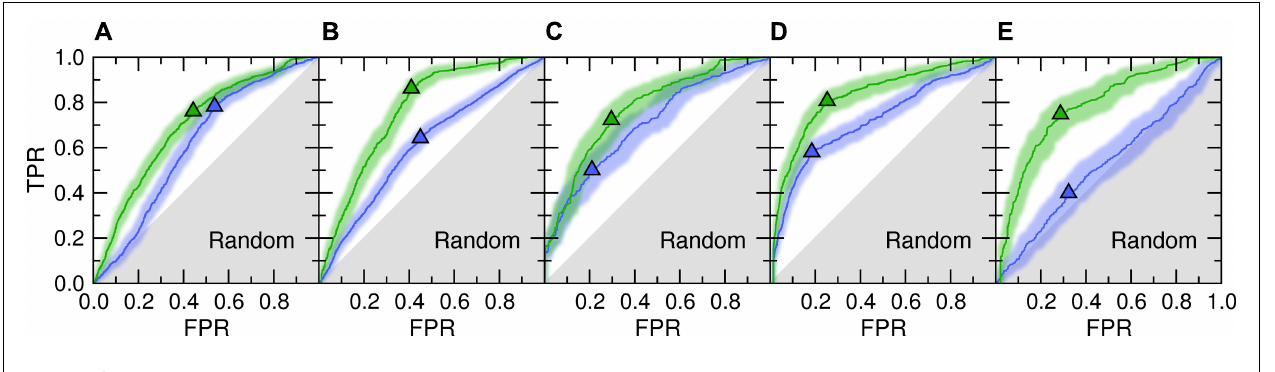
and bind chemically similar molecules or the binding mode is similar ( Feature , blue).Triangles depict optimal cut-off points; solid lines and transparent bands are the ROC curve and its non-parametric two-sided confidence bounds, respectively. Gray area corresponds to prediction accuracy no better than random.TPR, true positive rate; FPR, false positive